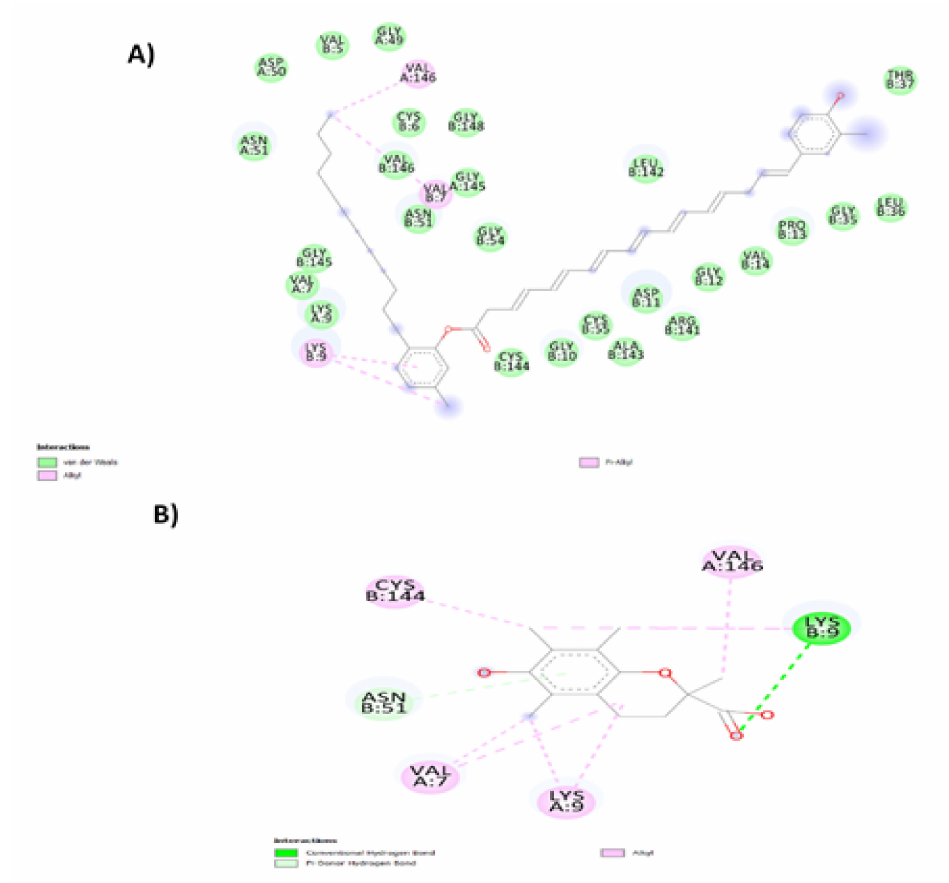
Figure 9. ( A ) Flexirubin and ( B ) Trolox interaction with amino acids on Cu/Zn superoxide dismutase enzyme chains generated by BIOVIA discovery studio visualizer (version